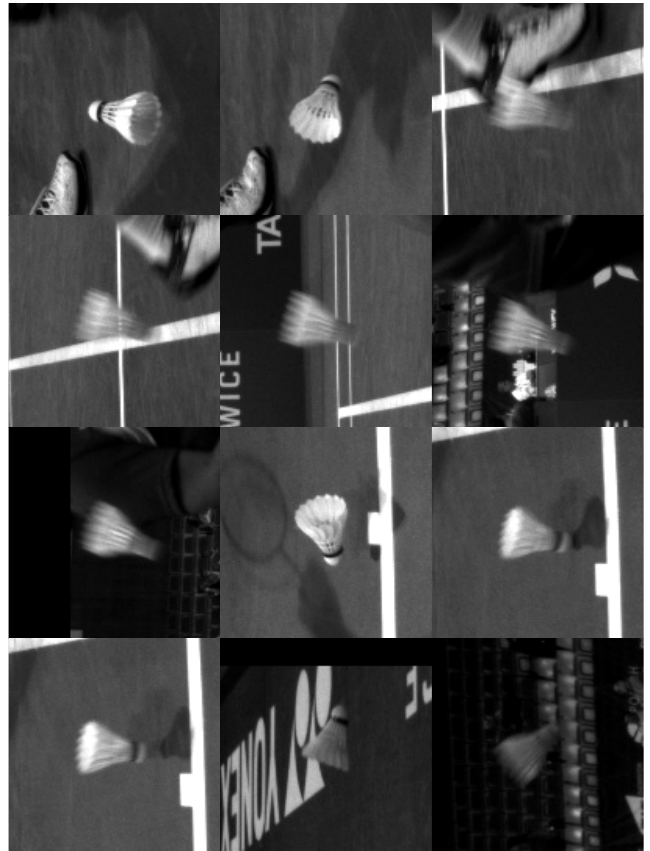
Sensors 2022 , 22 , x FOR PEER REVIEW Figure 10. Example of images passed to the neural network. Figure 10. Example of images passed to the neural network.